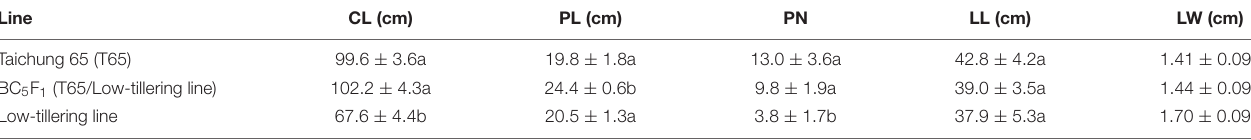
TABLE 2 | Agronomic traits of “Taichung 65” (T65), BC 5 F 1 (T65/low-tillering line), and low-tillering line.